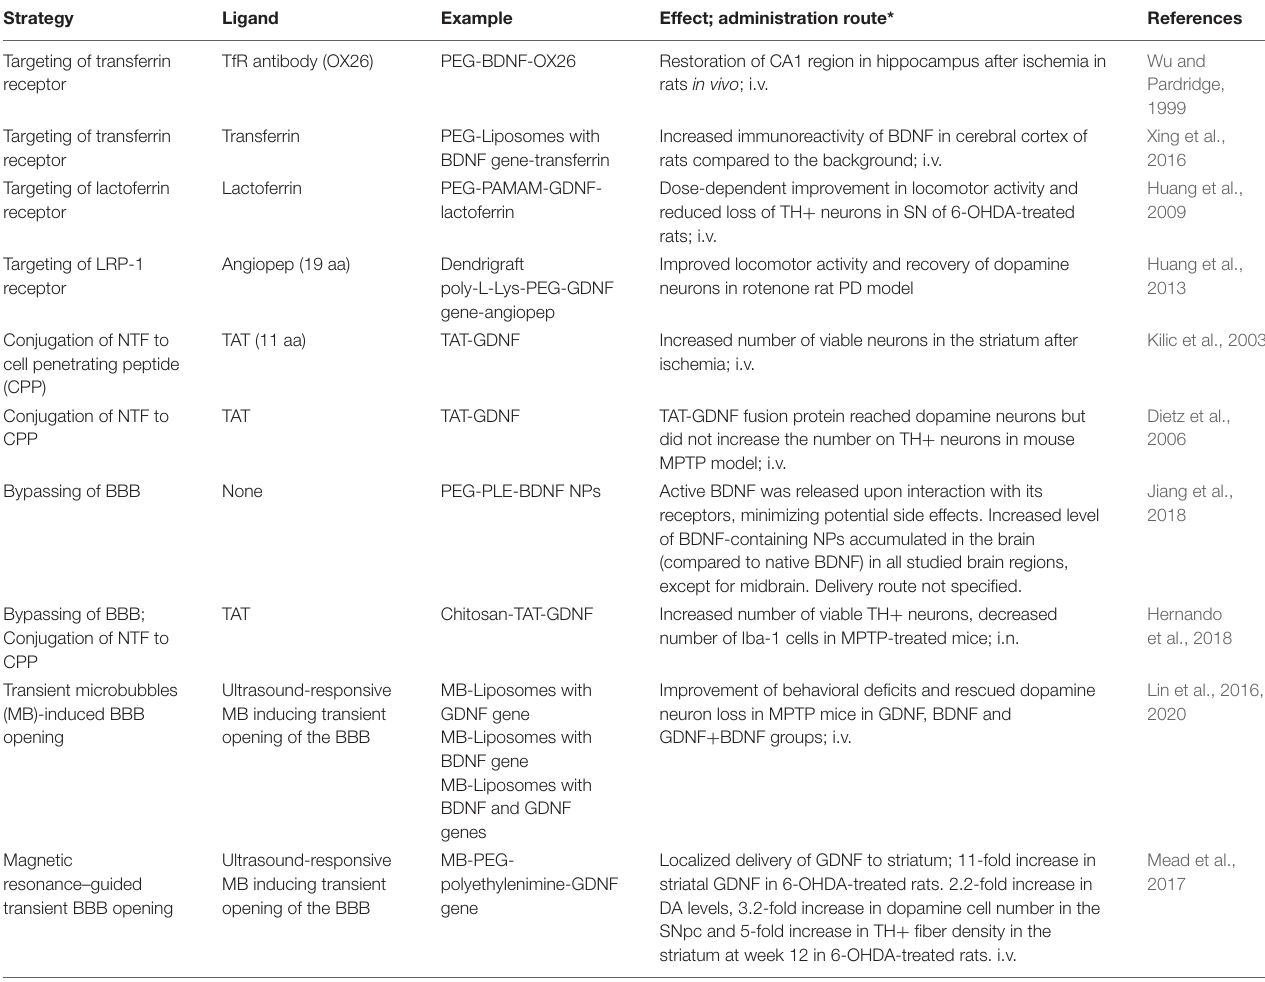
TABLE 2 | Ligands used for nanoparticles, for the transportation of neurotrophic factors through the blood–brain barrier.